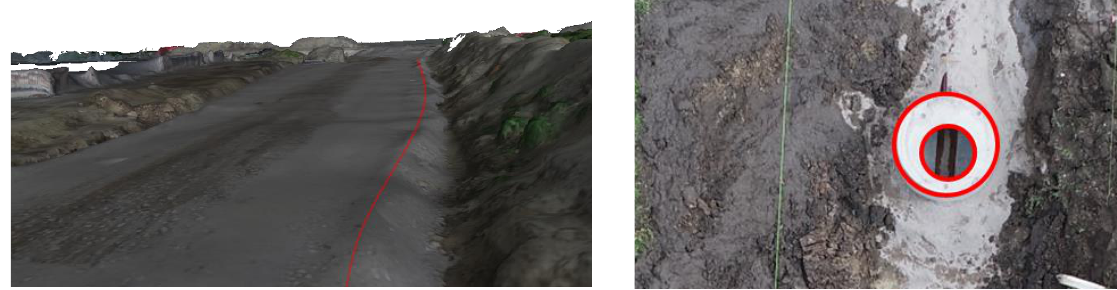
Figure 10. Manhole cover that isn't finished yet. The hole isn't centric with the pit itself.